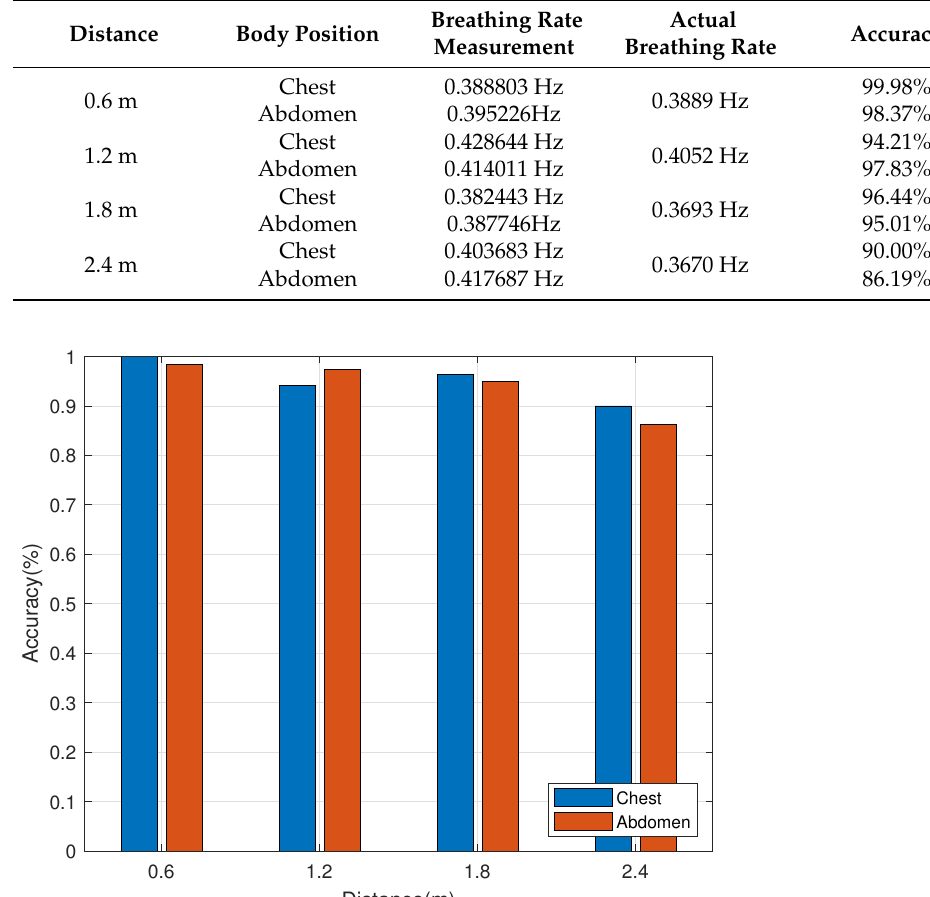
Figure 15. Experimental scenario for the distance comparison experiment. Table 2. Respiratory rate monitoring results at different distances.